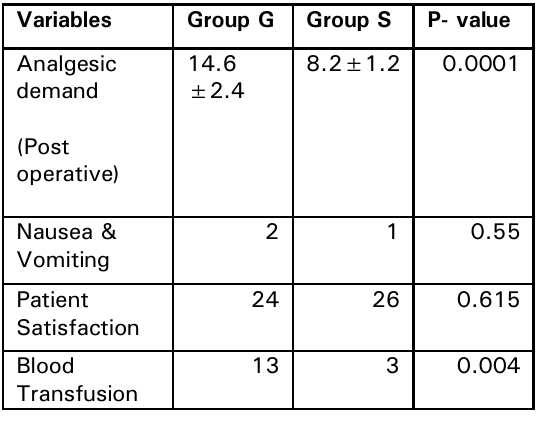
Table 5: Intraoperative Mean Heart Rate compared between two groups